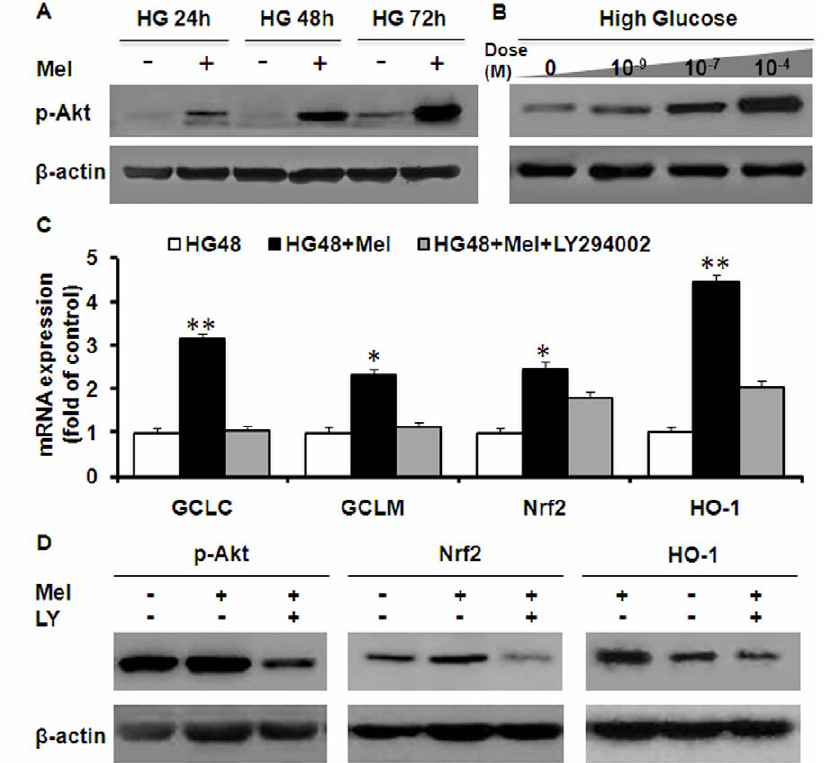
Figure 5. Effects of melatonin on Akt activation in Mu¨ller cells. (A) Cells were treated with 30 mM glucose either with or without 0.1 mM melatonin for indicated time. Akt phosphorylation was measured by Western blot analyses. (B) Dose-dependence of melatonin on Akt phosphorylation. (C) Effects of high glucose, melatonin and PI3K inhibitor LY294002 on antioxidant gene expression, as measured by real-time RT- PCR. (D) Effects of LY294002 on melatonin-mediated protective responses in Mu¨ller cells. Cells were treated with 30 mM glucose, melatonin or LY294002 for 48 hr. Akt phosphorylation, and the protein levels of Nrf2 and HO-1 were measured by Western blot analyses. (*P , 0.05; **P , 0.01).